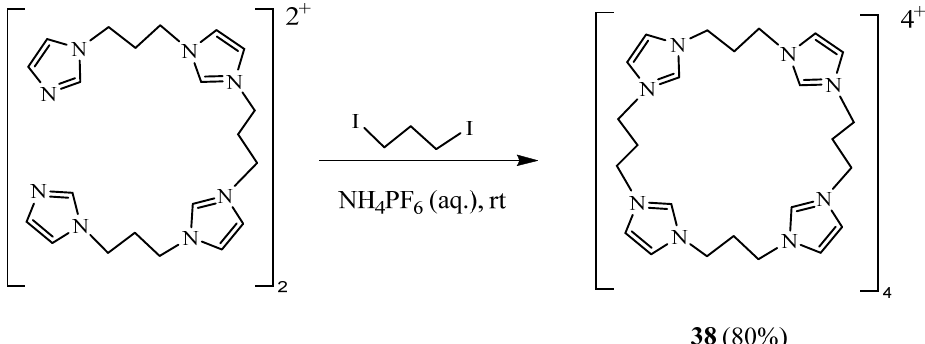
Figure 12. Synthesis of tetra-imidazolic macrocycle salt 38. (Reprinted with permission from ref. [27]. Copyright 2005 Royal Society of Chemistry).